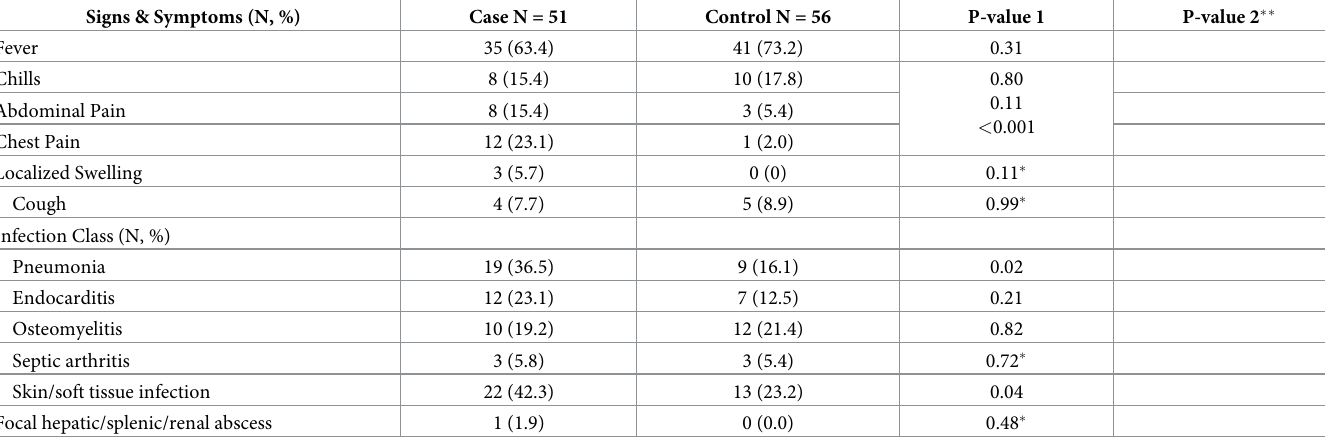
Table 2. Patient symptoms and infections by PVL 0 Case/Control status. Signs & Symptoms (N,